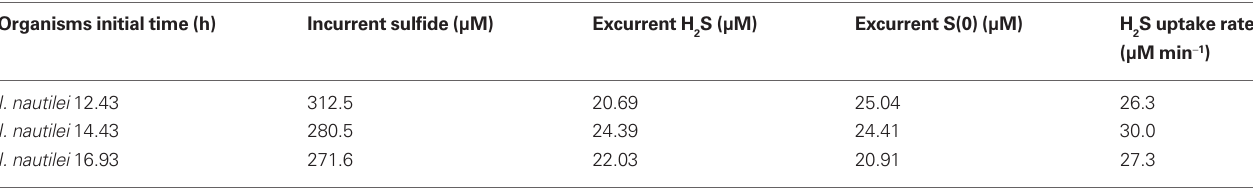
S with O using I. nautilei in high-pressure incubation chambers. 2 2